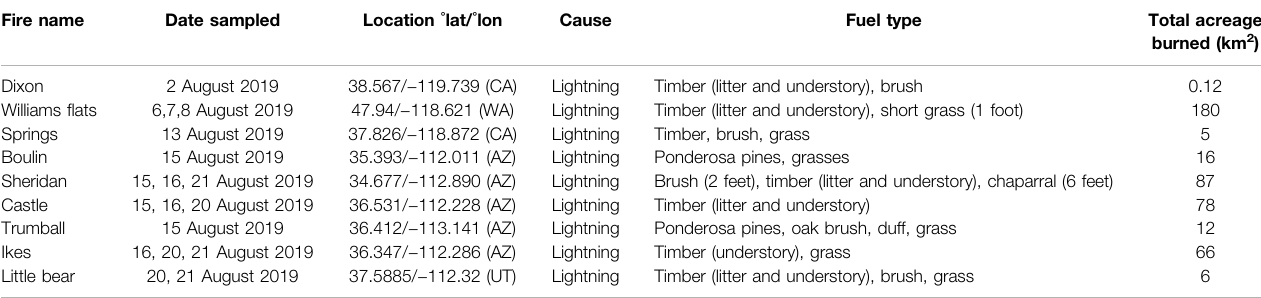
TABLE 1 | Summary of fi res sampled during the FIREX-AQ fi eld